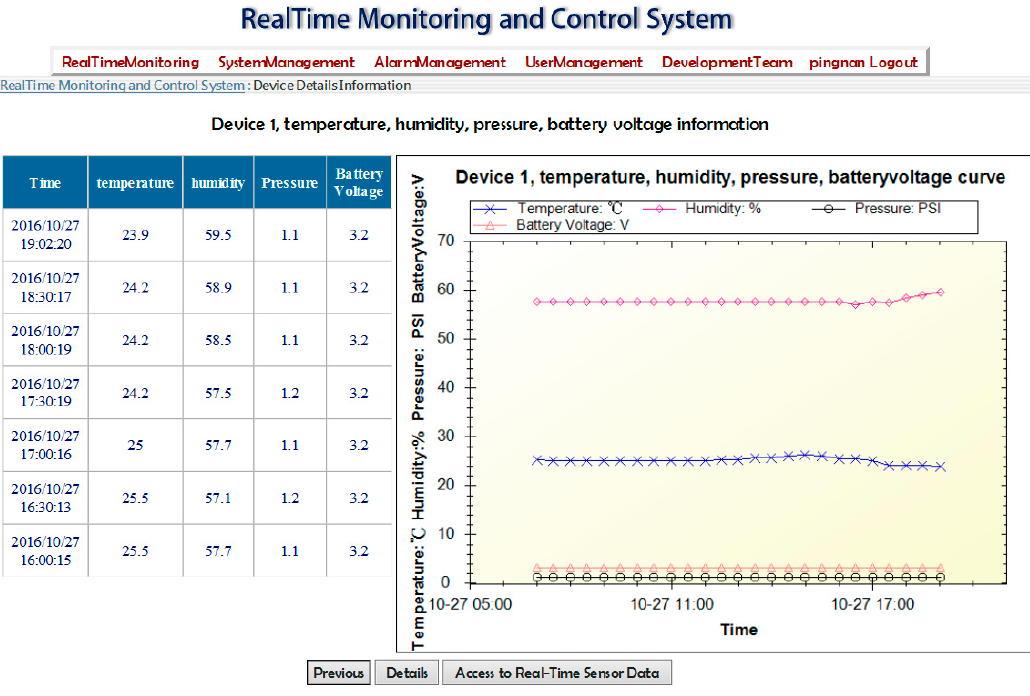
Figure 17. Temperature, humidity, pressure, and battery power of Sensor 1 in Scenario 2.